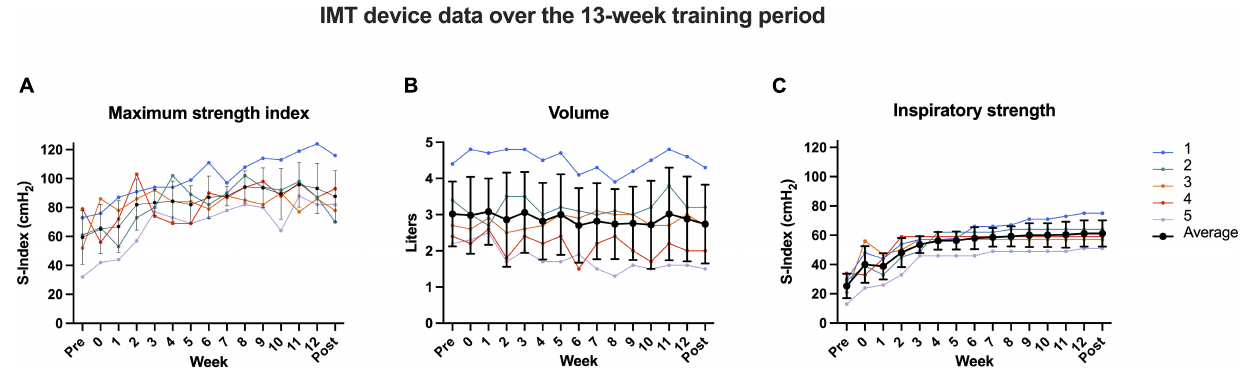
FIGURE 1 | Inspiratory muscle training (IMT) device data over the course of the intervention. Each colored line depicts a different participant, while the thick black line reflects the group average with its standard deviation. Panels: maximum inspiratory strength index (A) , respiratory volume in liters (B) , and average inspiratory strength (C) of five untreated OSA patients from baseline across 13 weeks of IMT. While participant 1 had a higher baseline on all measures and continued to increase both resistance and strength until the end of the trial, the average of the group reached a ceiling effect in strength index after approximately 8 weeks (with slight fluctuations) and after ca. 4 weeks in resistance.